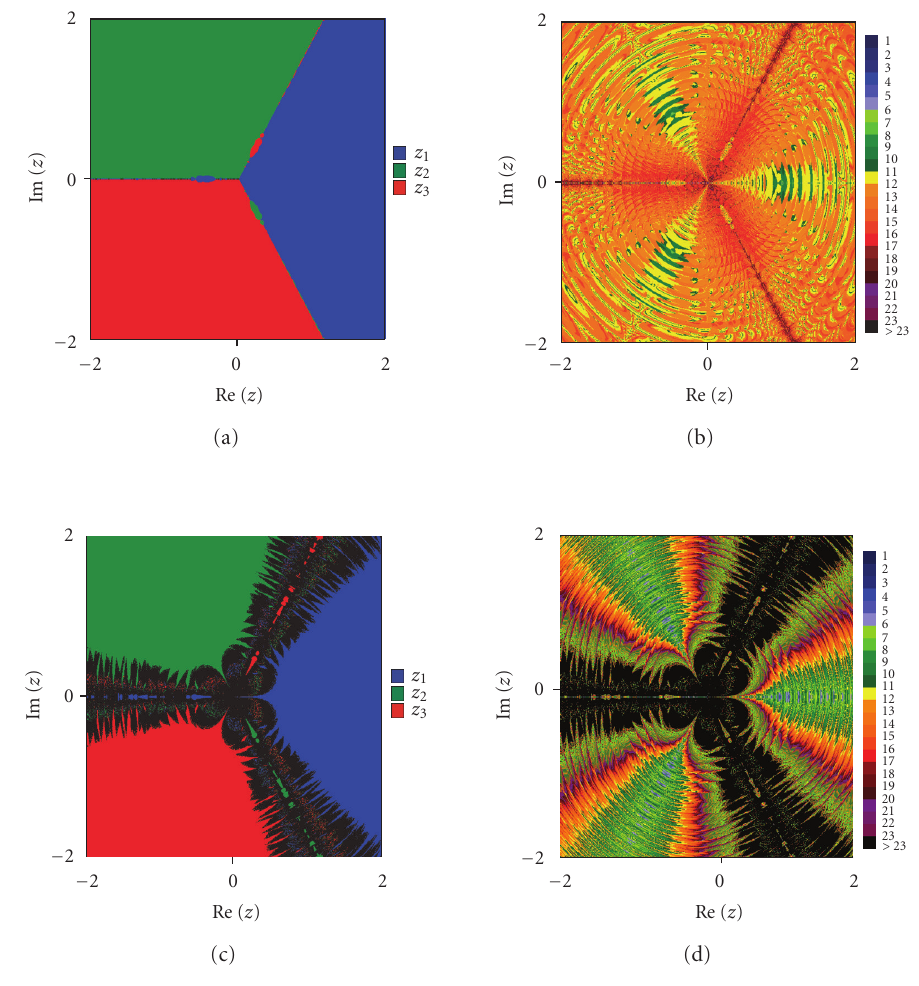
Figure 4.1. Basins of attraction for z 3 − 1 = 0. (a)–(b) Using CG-PR method and W-L.S. (c)–(d) Using CG-FR method and